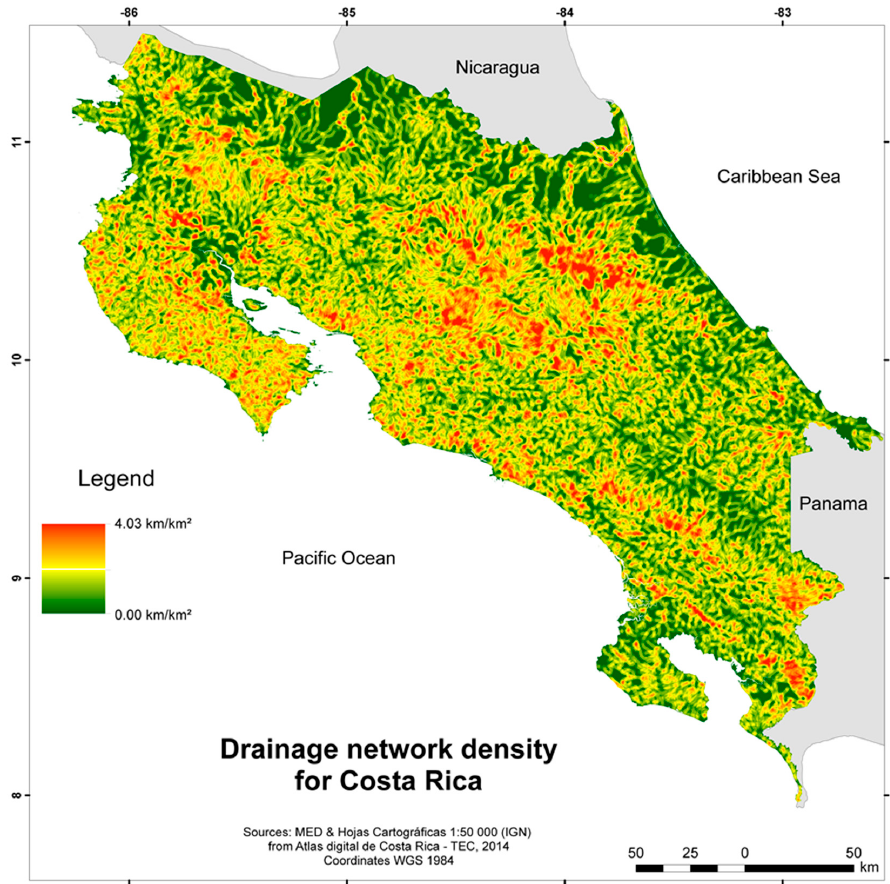
Figure 5. Drainage network density for Costa Rica based on the cartography maps (IGN) on a 1:50,000 scale digitalized by TEC [44].